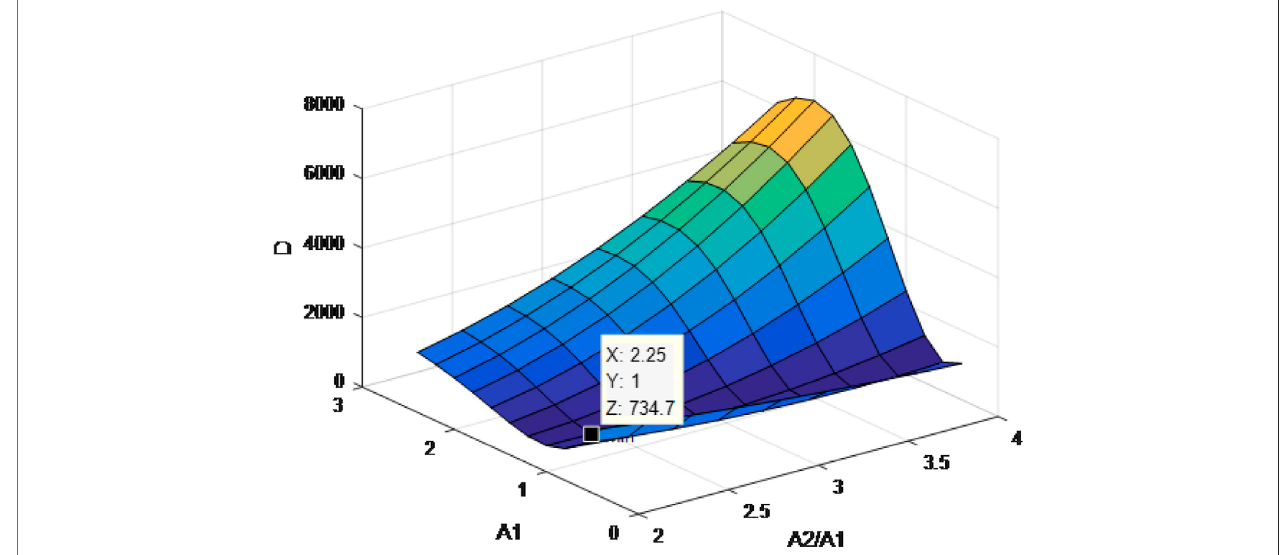
FIGURE 10 | Simulation of mean square error of non-uniform